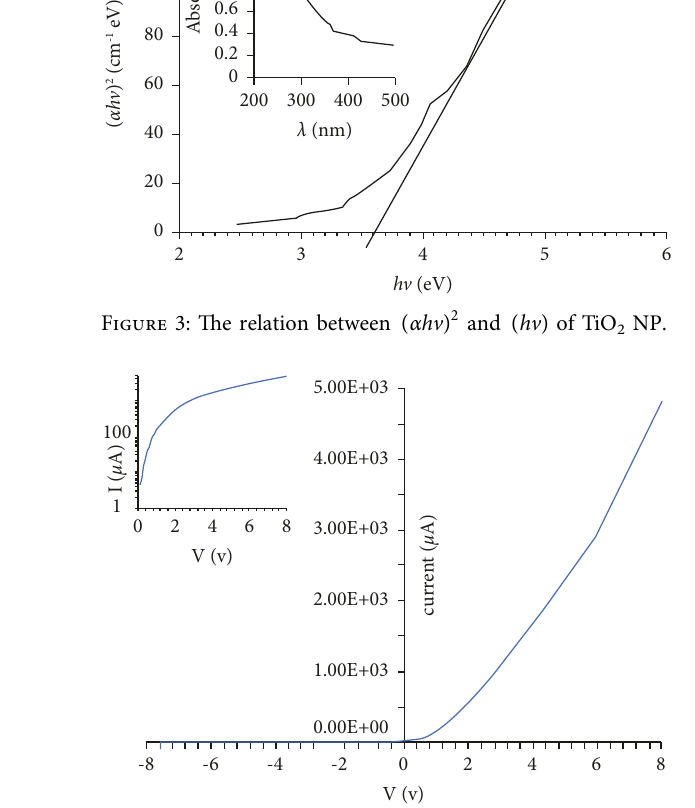
Figure 4: I dark –V features of the TiO 2 NPs photodetector. In the insert figure, Semi-log I f – V